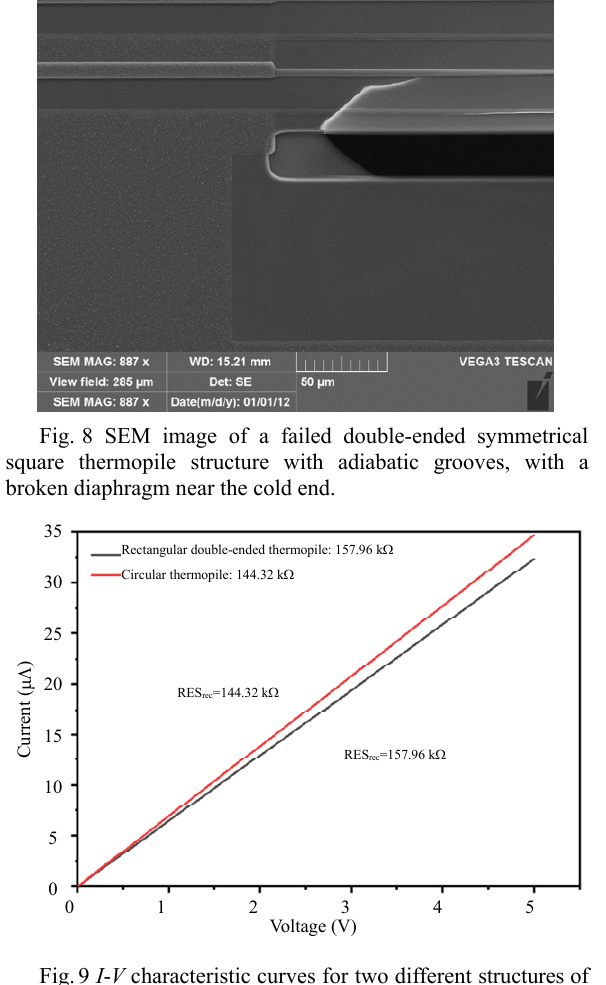
Fig. 9 I - V characteristic curves for two different structures of